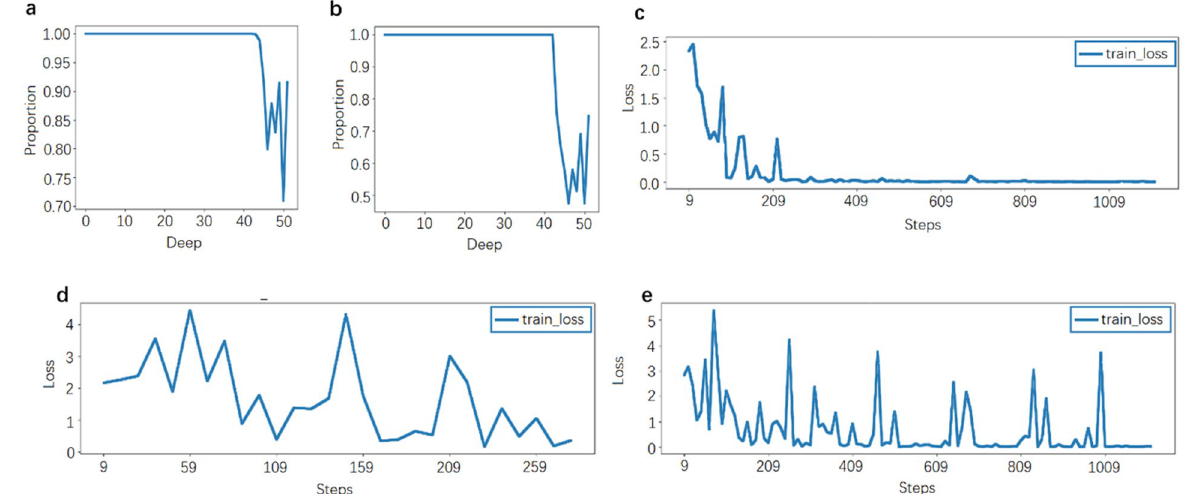
Figure 5. Effectiveness analysis results of convolution head. ( a ) Proportion of similar feature maps of each layer using threshold M. ( b ) The proportion of similar feature maps of each layer using threshold M/2. ( c ) The Darknet part of the pre-trained YOLOv3 model is used for the training convergence process of classification tasks. ( d ) The Darknet part of the untrained YOLOv3 model is used for the training convergence process of classification tasks. ( e ) Convergence of CNN training process using Darknet